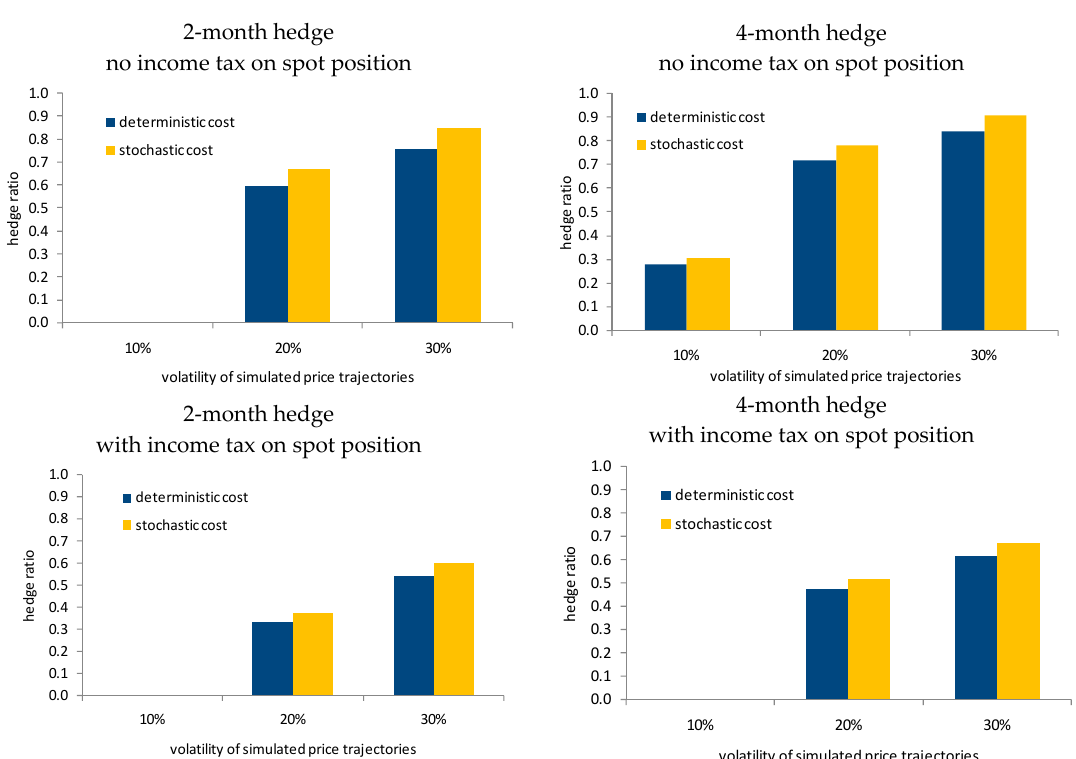
Figure 1. Hedge ratios with deterministic and stochastic transaction costs in futures trading.